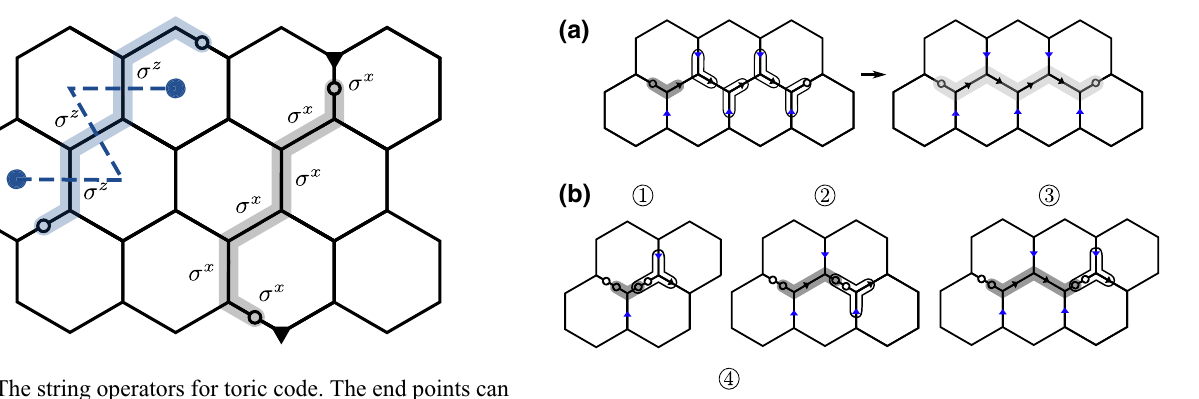
FIG. 7. The string operators for toric code. The end points can be labeled by a plaquette or vertex that corresponds to exactly the microscopic excitation in Eq. (1). The dashed line indicates the path that the plaquette excitation takes as the Wilson string is generated.